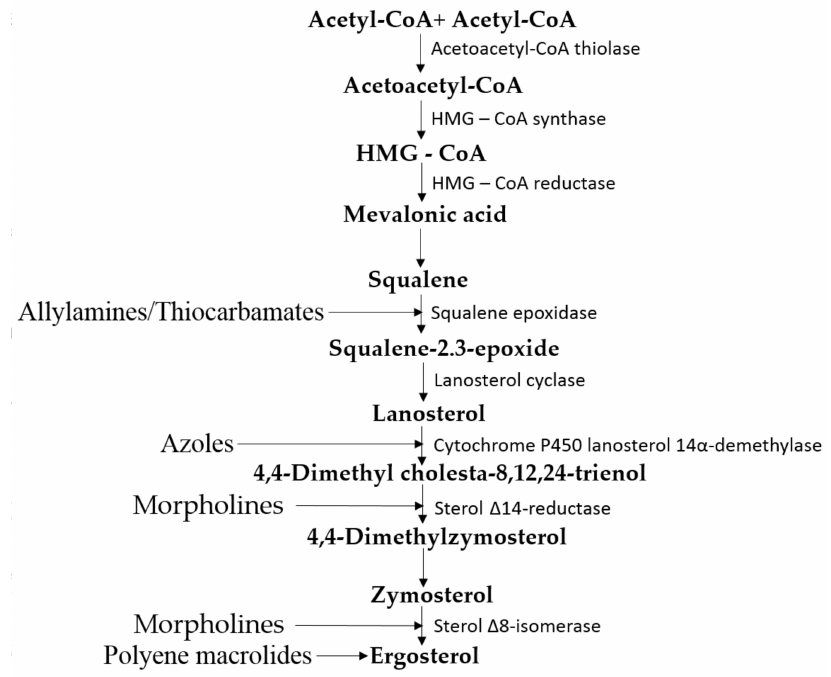
Figure 2. Antifungal interference with ergosterol biosynthesis. This figure is adapted and modified from Ref. [24]. HMG-CoA, β -Hydroxy- β